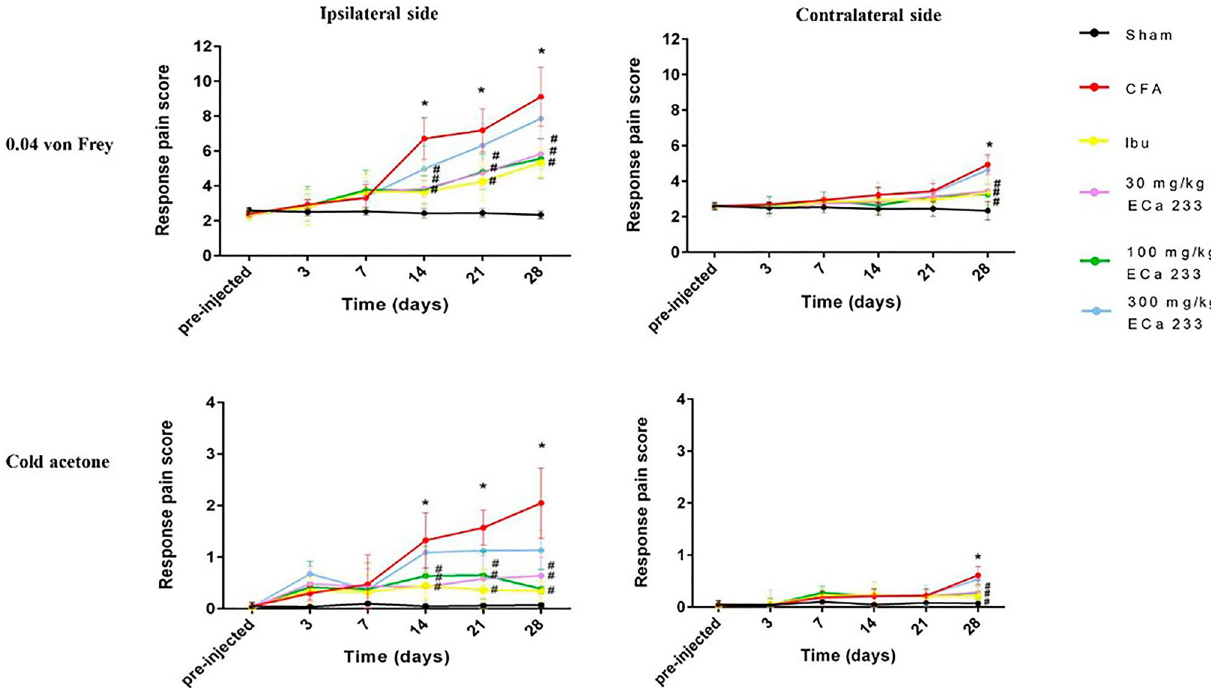
Figure 2. Pain response scores tested by von Frey filament and cold acetone tests performed at different time points in all groups. In the complete Freund’s adjuvant (CFA) group, the pain scores of all behavioral tests significantly increased on the ipsilateral side at post–CFA-injection days 14 [F(5,48) = 16.187, P < 0.05] and 21 [F(5,48) = 15.159, P < 0.05], and 28 [F(5,48) = 18.299, P < 0.05] as per von-Frey test and at days 14 [F(5,48) = 11.367, P < 0.05], 21 [F(5,48) = 12.357, P < 0.05] and 28 [F(5,48) = 17.045, P < 0.05] as per cold acetone test, and on the contralateral side at post-CFA-injection day 28 [F(5,48) = 19.543, P < 0.05, F(5,48) = 17.697, P < 0.05, von-Frey test and cold acetone test, respectively]. In the Ibu, 30ECa, and 100ECa groups, the pain scores significantly decreased on the ipsilateral side, but not in the 300ECa group, at